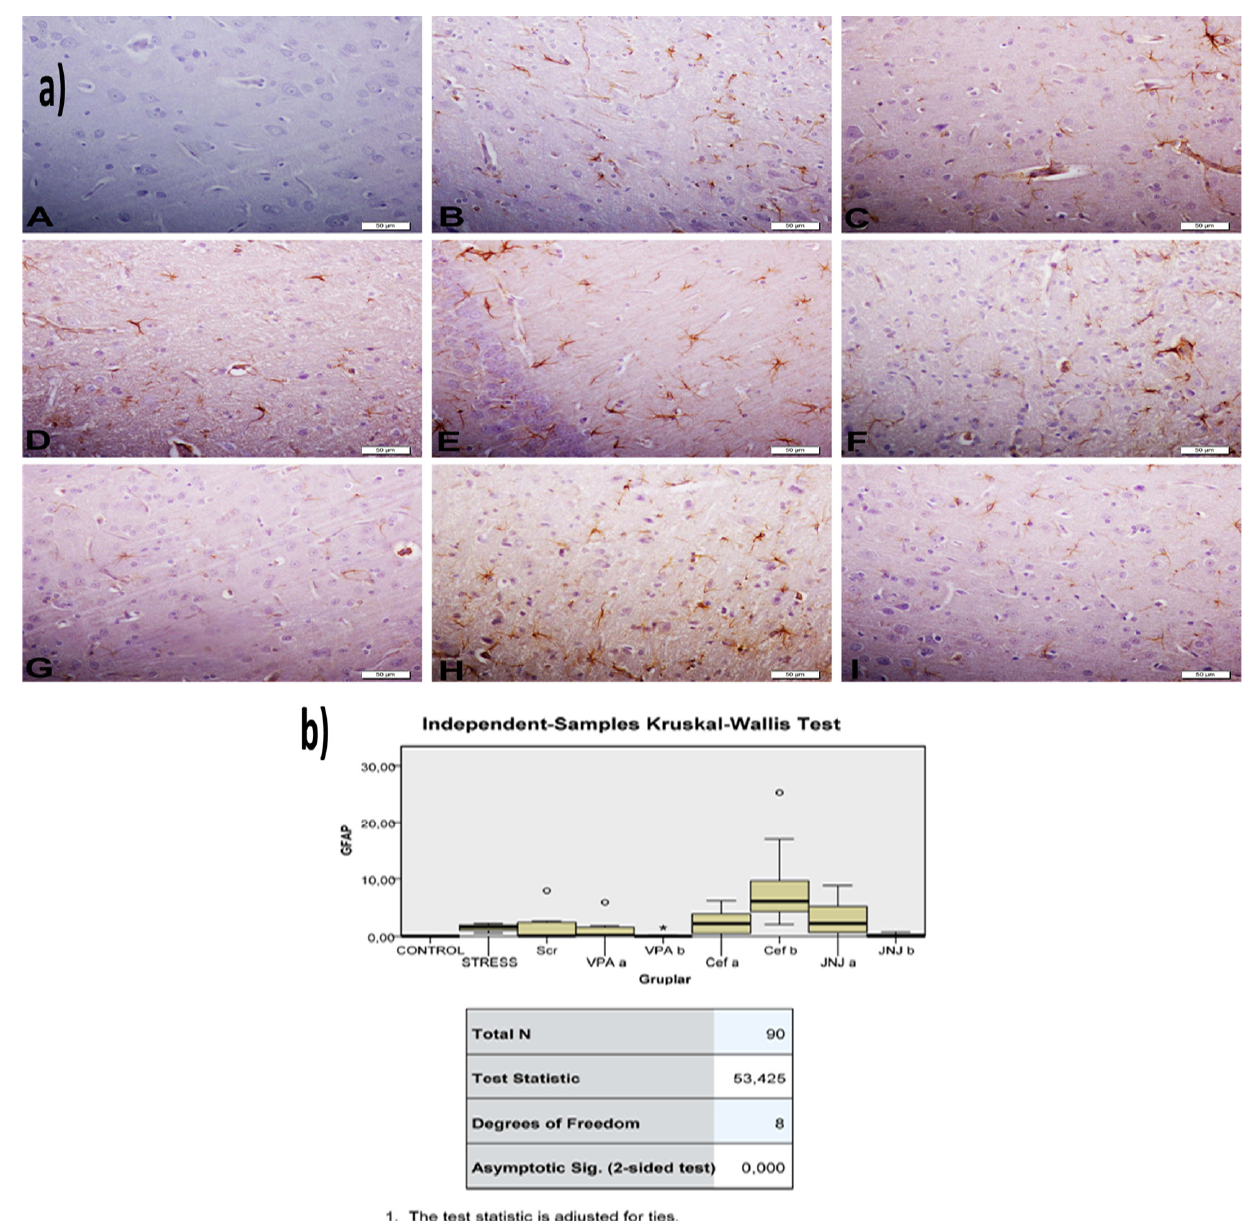
Figure 8. ( a ) GFAP images of experimental groups. Histopathological images of A (Control), B (Stress), C (Ser), D (VPAa), E (VPAb), F (Cefa), G(Cefb), H (JNJa), and I (JNJb). IHC-P—immunohistochemistry-paraffin protocol. ( b ) Quantitative analysis of IHC and immunofluorescence staining, mean immunoreactivity intensity was determined using ImageJ software (ImageJ). p < 0.05 was considered statistically significant.